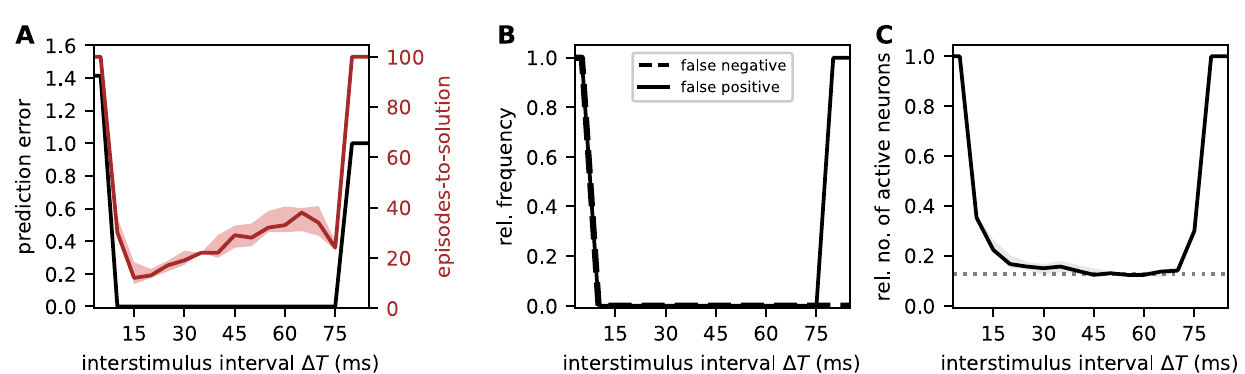
Fig 10. Effect of sequence speed on network performance. Dependence of the sequence prediction error, the learning speed (episodes-to-solution; A ), the false-positive and false-negative rates ( B ), and the number of active neurons relative to the subpopulation size ( C ) on the inter-stimulus interval Δ T after 100 training episodes. Curves and error bands indicate the median as well as the 5% and 95% percentiles across an ensemble of 5 different network realizations, respectively. Same task and network as in Fig 8.